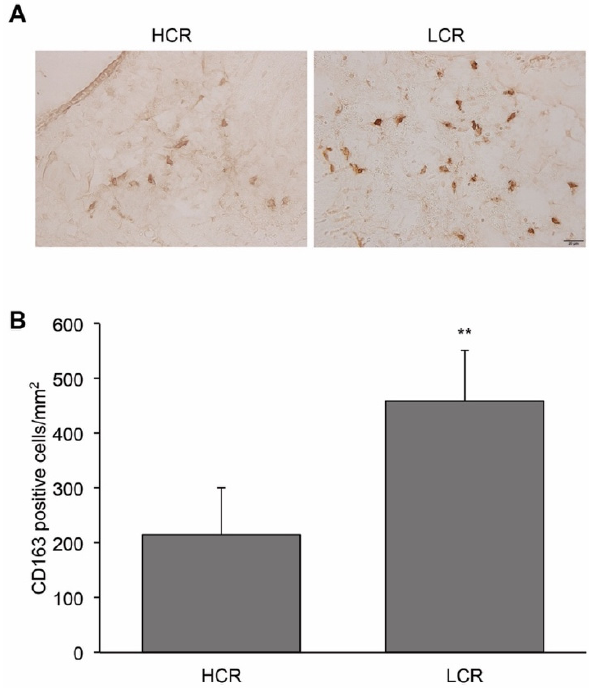
Figure 4. The number of CD163-positive cells after SAH was greater in LCR rats than in HCR rats. ( A ) Representative images of periventricular CD163 immunohistochemistry 24 h after SAH in HCR and LCR rats. Scale bar = 20 μ m. ( B ) Quantification of the number of CD163-positive cells after SAH. Values are mean ± SD; ** p < 0.01 versus HCR group.